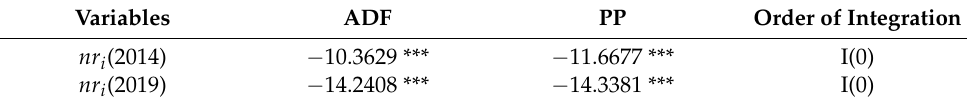
Table 2. Unit root tests: stationary